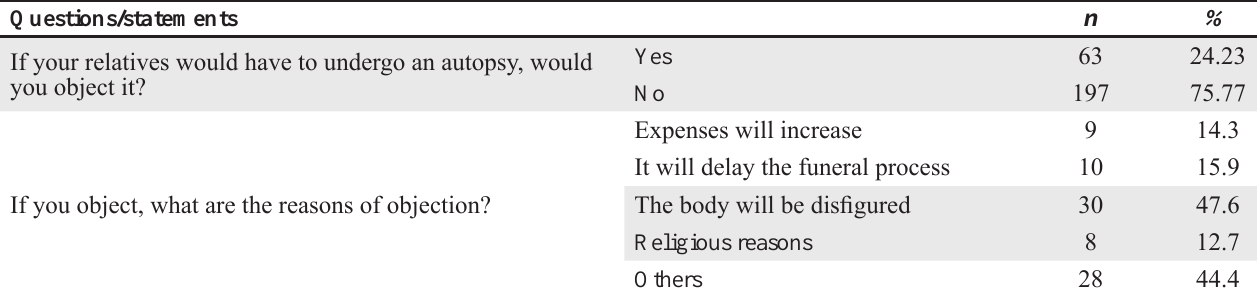
Table 3 : Perception of medico legal autopsy about objection (N = 260) Questions/statements